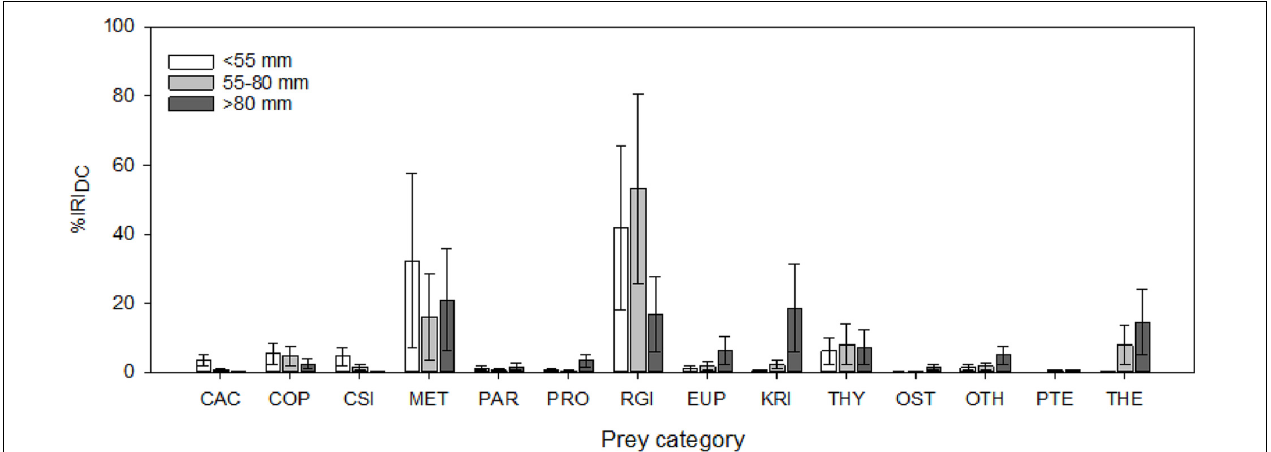
FIGURE 2 | Variation in the diet composition of the Scotia Sea community with body size (SL, mm), expressed as the percentage index of relative importance (%IRI DC ). Error bars are bootstrapped 95% confidence intervals. CAC, Calanoides acutus ; COP, other copepods; CSI, Calanus simillimus ; MET, Metridia spp.; PAR, Paraeuchaeta spp.; PRO, Pleuromamma robusta ; RGI, Rhincalanus gigas ; EUP, other euphausiids; KRI, Euphausia superba ; THY, Thysanoessa spp.; OST, ostracods; OTH, other taxa (predominantly unidentified crustaceans); PTE, pteropods; THE, Themisto gaudichaudii